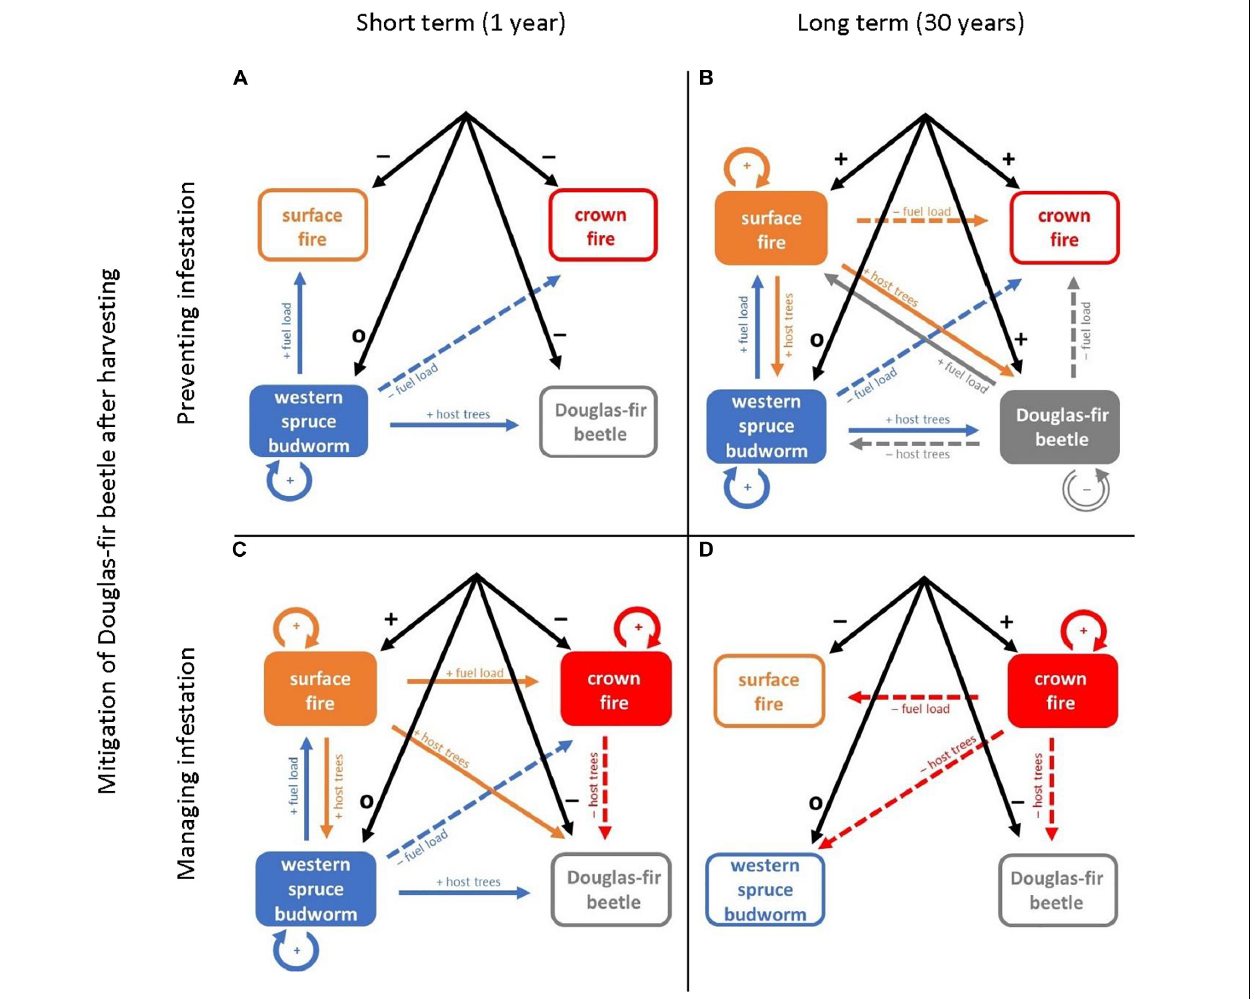
FIGURE 4 | Conceptual models of disturbance interactions following harvesting to enhance mule deer winter habitat in Douglas-fir-dominated forests. Four scenarios (A–D) contrast time since harvesting (1 year or 30 years, columns) and options to mitigate Douglas-fir beetle infestations after harvesting (preventing or managing infestatios, rows). Solid rectangles indicate self-reinforcing disturbances; open rectangles indicate disrupted disturbances. Black arrows indicate management impacts on disturbance: “ + ” symbols indicate net positive effects, “ − ” symbols indicate net negative effects, and “o” indicates no net effect or a neutral interaction. Solid color arrows and “ + ” symbols indicate net positive interactions between disturbances. Dashed color arrows and “ − ” symbols indicate net negative effects. Arrow colors correspond to the causal disturbance agent and point toward the affected disturbance; labels identify key mechanisms of interaction.